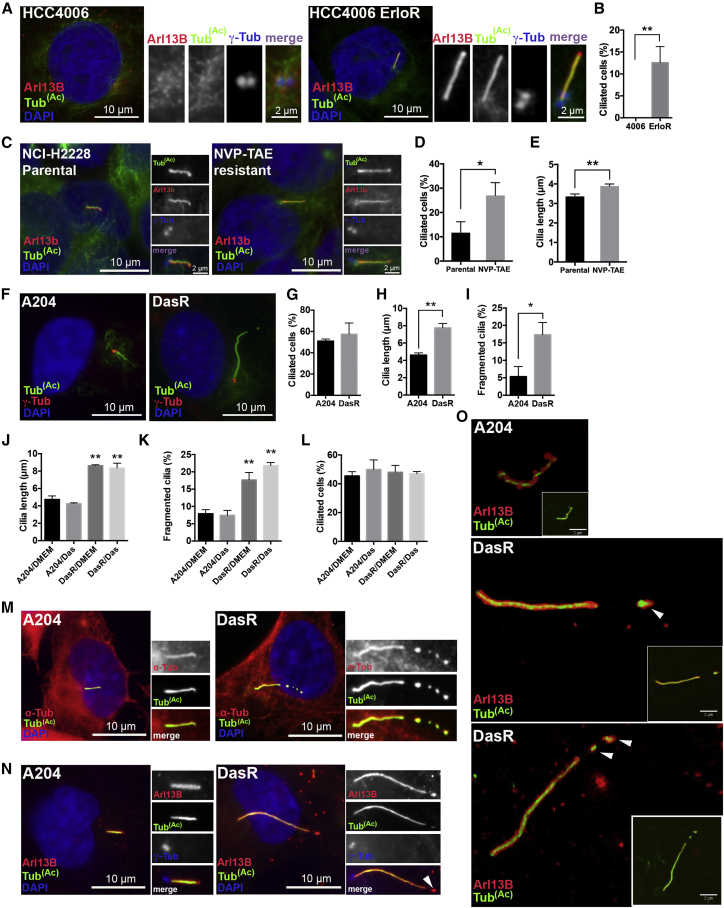
Acquired Resistance to Kinase Inhibitors in Human Cancer Cell Lines Is Associated with Increased Cilia Frequency, Cilia Length, and Cilia Tip Fragmentation(A) Control (left panels) or erlotinib-resistant (ErloR) (right panels) HCC4006 lung adenocarcinoma cells were serum starved for 48 hr to induce ciliogenesis, then fixed and stained with antibodies for acetylated tubulin (green) and Arl13B (red) to mark cilia, γ-tubulin (blue/inset) for centrioles, and DAPI (blue) to mark DNA. Note that primary cilia are absent in parental HCC4006 cells but are present in the erlotinib-resistant subline.(B) Quantification of experiment shown in (A). n = 300. Error bars represent SD. p < 0.005, unpaired t test.(C) Parental (left panels) or NVP-TAE684 (NVP-TAE)-resistant (right panels) NCI-H2228 lung adenocarcinoma cells were serum starved for 48 hr to induce ciliogenesis, and then fixed and stained with antibodies for acetylated tubulin (green) and Arl13B (red) to mark cilia, γ-tubulin (blue/inset) for centrioles, and DAPI (blue) to mark DNA.(D and E) Quantification of ciliated cells (D) and cilia length (E) shown in (C). n = 300 for (D) and n = 150 for (E). Error bars represent SD. p < 0.02 (D) and p < 0.005 (E), for an unpaired t test. Note that primary cilia were shorter in parental cells compared to the NVP-TAE684-resistant subline.(F) Rhabdoid tumor A204 cells (left panel) or a dasatinib-resistant (DasR) subline (right panel) were stained with acetylated tubulin to mark cilia (green), γ-tubulin (red), and with DAPI (blue).(G) Quantification of fraction of ciliated cells for the experiment shown in (F) (n = 300).(H and I) Quantification of cilia length (H) (n = 150) and cilia fragmentation (I) (n = 150) for the experiment shown in (F). Error bars represent the SD. p < 0.0007 for (H) and p < 0.011 for (I), unpaired t test. Note that DasR cells show increased cilia length and cilia fragmentation.(J–L) Quantification of primary cilia length (J), cilia fragmentation (K), and percentage of ciliated cells (L) for A204 or DasR cells grown with (Das) or without (DMEM) dasatinib for 48 hr, and then serum starved in the presence (Das) or absence (DMEM) of dasatinib for 48 hr. n = 150 cilia. The error bars represent the SD. p < 0.0001 for (J) and (K), Tukey’s multiple-comparison test, statistical significance calculated by comparing DasR/DMEM and DasR/Das to A204/DMEM and A204/Das.(M) A204 (left) or DasR (right) cells were serum starved to induce ciliogenesis, and then fixed and stained for α-tubulin (red) to mark all microtubules, acetylated tubulin (green) for cilia, and DAPI for DNA (blue). Note that α-tubulin is present along the entire cilium axoneme in both A204 and DasR cells and it follows cilia fragmentation in DasR cells (right).(N) A204 (left) or DasR cells (right) were stained for Arl13B to mark ciliary membranes (red), acetylated tubulin (green), γ-tubulin (blue/inset), and DAPI (blue). Arrow indicates cilia fragments marked by both acetylated tubulin and Arl13B in DasR cells.(O) 3D structured illumination images of A204 and DasR cilia; Arl13B is shown in red and acetylated tubulin in green. Note that, at this resolution, Arl13B signal surrounds acetylated tubulin. Arrows indicate budding fragments in DasR cells that contain membrane around them, suggesting an active budding event.